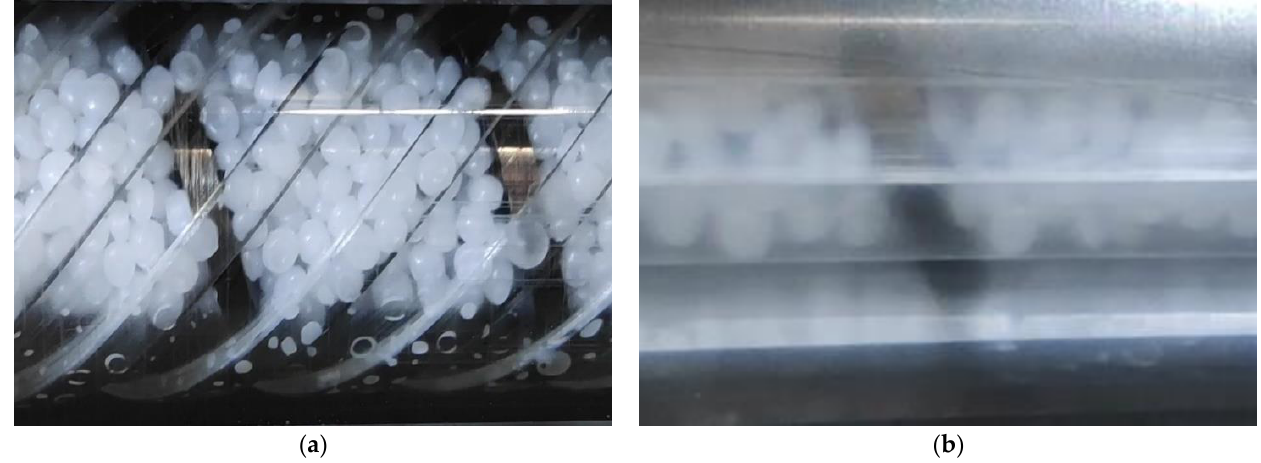
Figure 8. Virgin PP granule processed with a transparent PMMA barrel exhibiting ( a ) helical grooves ( b ) axial grooves.